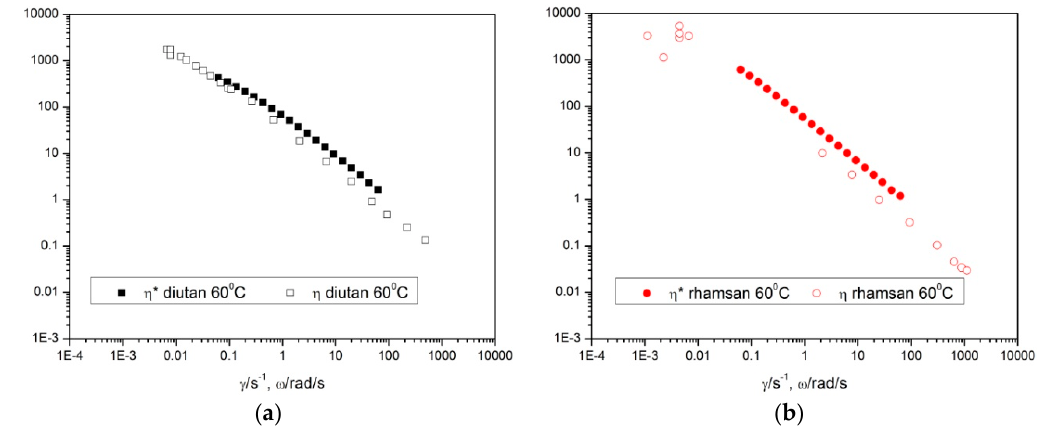
Figure 6. Apparent viscosity and complex viscosity versus shear rate and frequency of aqueous solutions containing ( a ) 1 wt % diutan gum and ( b ) 1 wt % rhamsan gum. Temperature 60 °C.